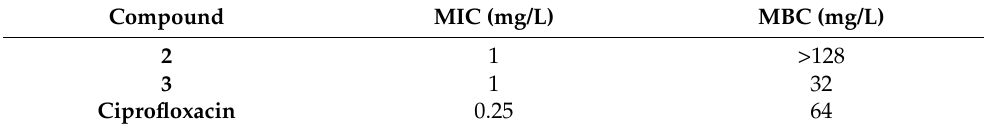
Table 3. MIC and MBC values of the newly synthesized quinolones against E. coli .